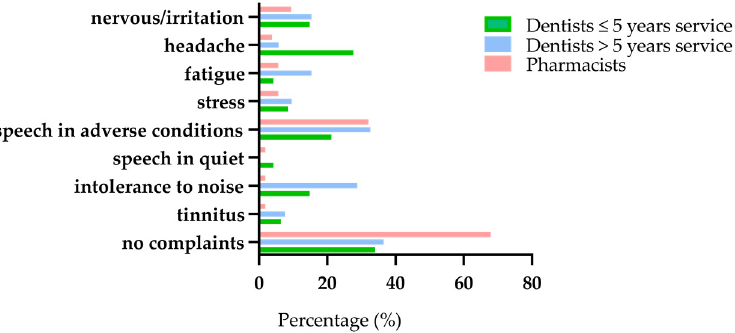
Figure 2. Potential complaints related to occupational noise exposure of the two groups of dentists and the controls.